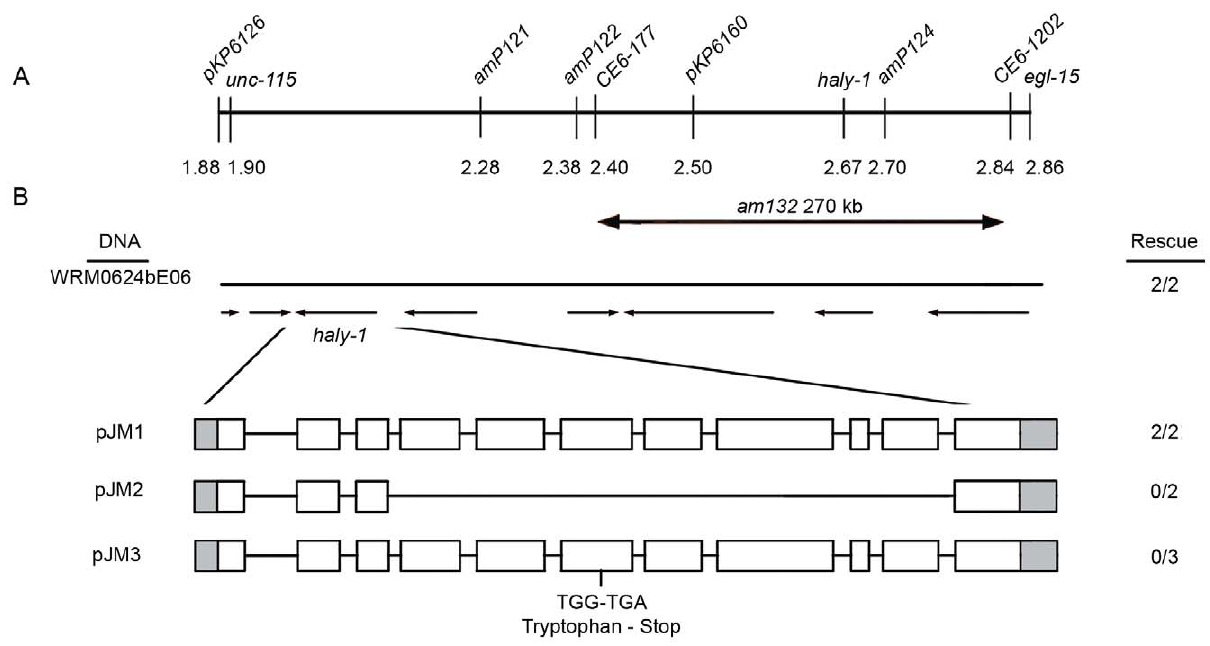
Figure 2. Positional cloning of haly-1. (A) A genetic map of chromosome X. Loci defined by mutations that cause visible phenotypes and SNPs are indicated above, and map units are shown below. Three-factor mapping experiments positioned am132 between unc-115 and egl-15 . Multi-factor mapping experiments positioned am132 between the SNPs CE6-177 and CE6-1202 , an interval of 270 kb. (B) Lines indicate DNA, boxes represent exons, and shading represents untranslated regions. The fosmid WRM0624bE06 includes eight predicted ORFs shown as arrows indicating orientation of transcription, including haly-1 (F47B10.2). Plasmid pJM1 included only the wild-type haly-1 ORF, whereas pJM2 has a deletion mutation and pJM3 has a nonsense change identical to haly-1(am132) . Rescue indicates the number of independently derived transgenic strains that displayed wild-type zinc tolerance over the total number of transgenic strains analyzed.